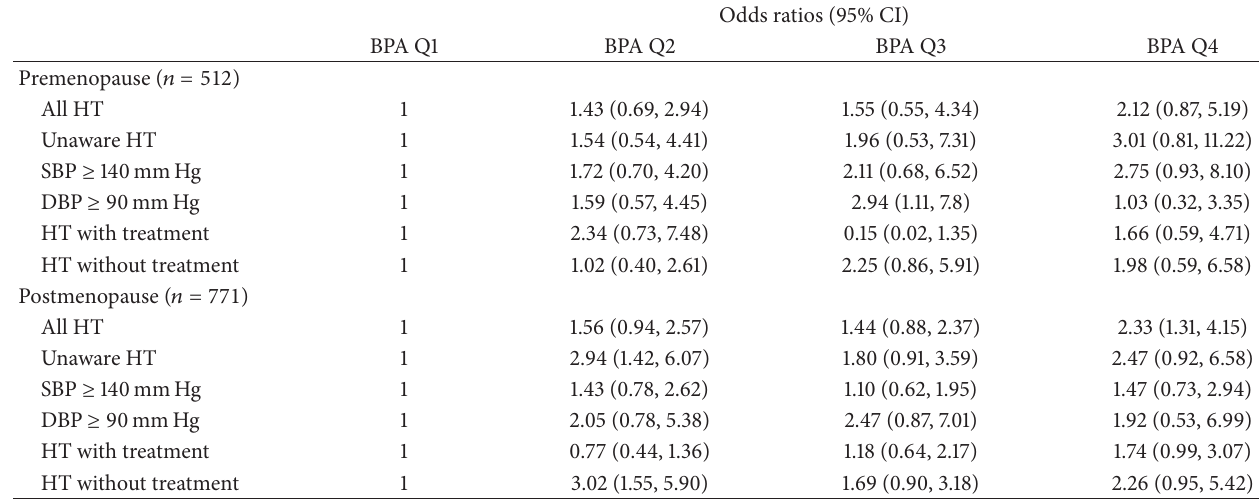
Table 6: Adjusted odds ratio (AOR) for high blood pressure according to quartile of serum BPA among premenopausal and postmenopausal women.